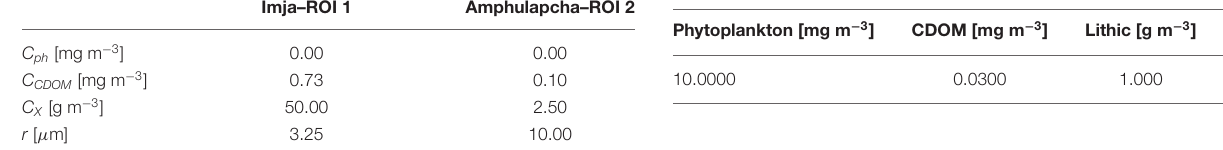
TABLE 4 | Concentrations and grain size used to match Hyperion reflectances. TABLE 5 | Concentrations and grain size used to RrsObsSyn1.txt synthetic data generation.